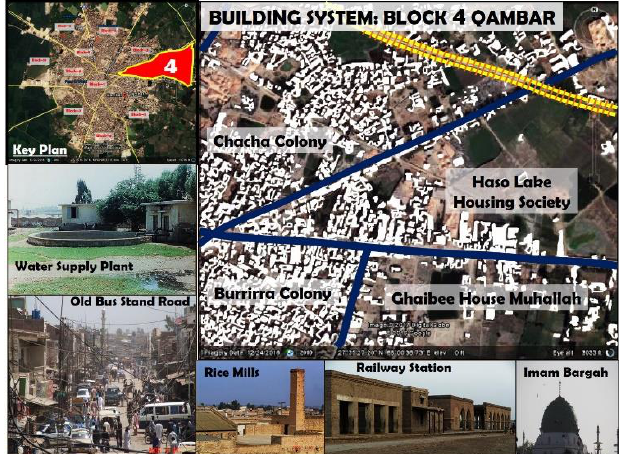
Fig. 8. Town plan analysis of Qambar: building system with varying densities in urban block 4